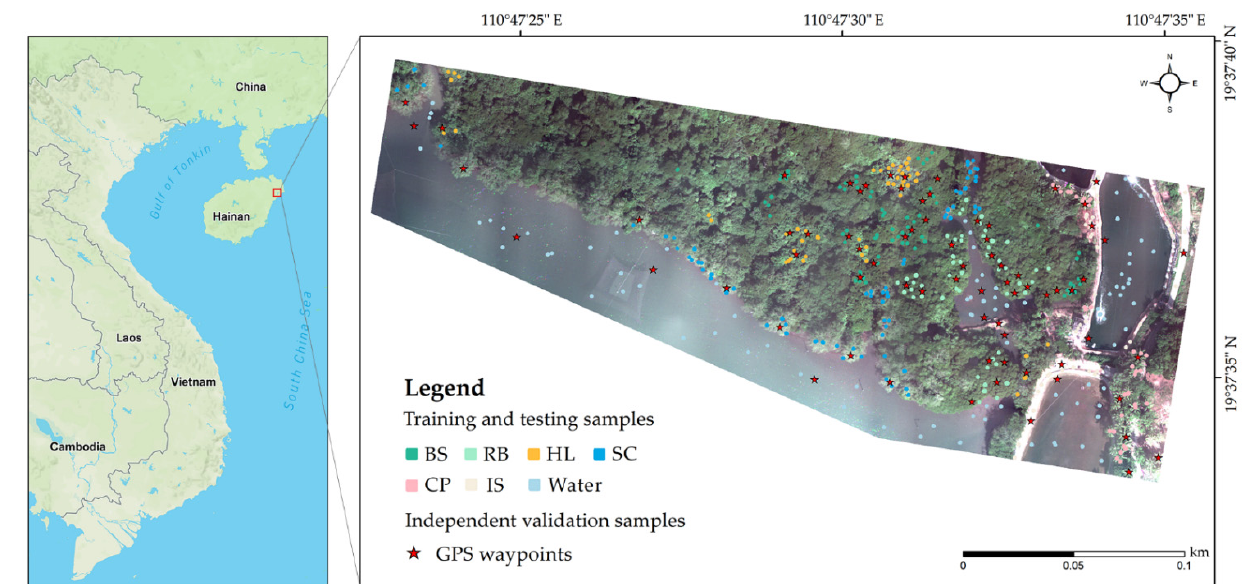
Figure 1. Map of the study area, Hainan, and the field samples. Note: Rhizophora apiculata Blume (RB), Bruguiera sexangula (BS), Hibiscus tiliaceus Linn. (HL), Sonneratia caseolaris (SC), and impervious surface (IS).